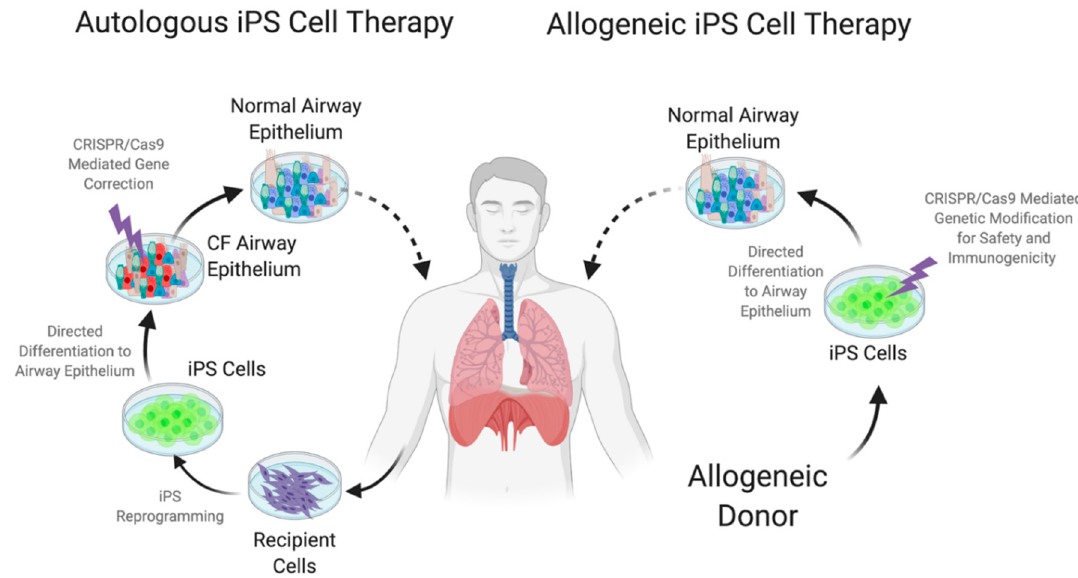
Figure 4. Schematic representation of cell-based therapeutic approaches using induced pluripotent stem cells. In autologous iPS cell therapy, somatic cells are isolated from the CF patient, expanded and reprogrammed to produce patient-specific induced pluripotent cells. These cells are subsequently differentiated to proximal airway epithelium, corrected for the genetic defect to achieve normal airway epithelium and transplanted back to the patient. In allogeneic iPS cell therapy, a universal iPS line (from a healthy source) which has been genetically modified for safety and immunogenicity is used to generate proximal airway epithelium which is transplanted to CF patients. Figure created with BioRender.com.